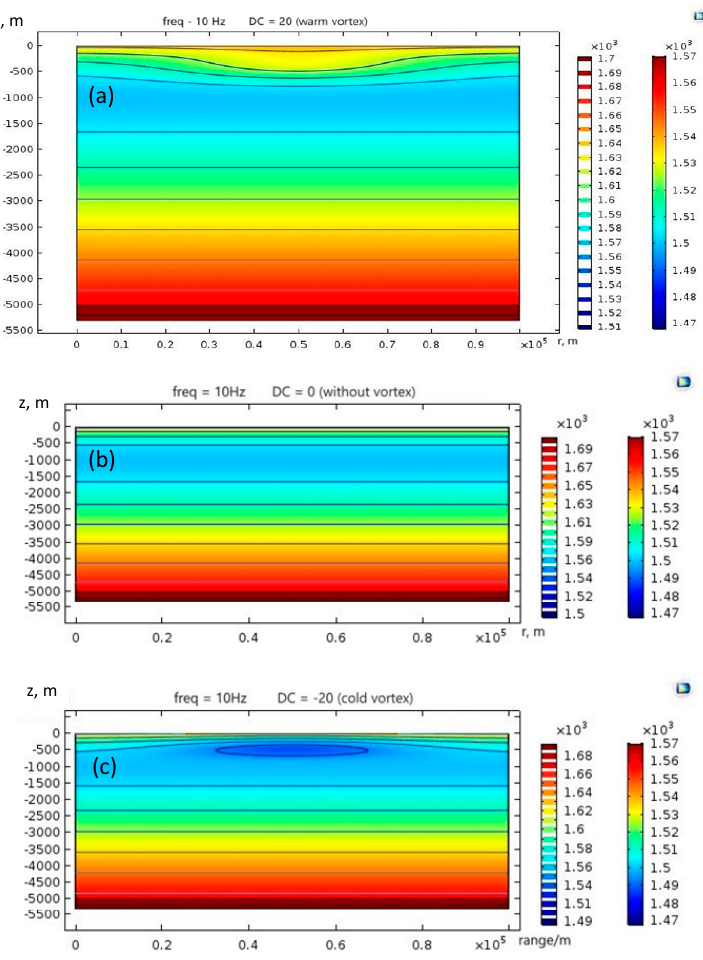
Figure 11. The vertical plane of sound velocity (m/s) distribution when vortices with different DC values exist ( a ) DC = − 20 m/s, ( b ) DC = 0, and ( c ) DC = 20 m/s.